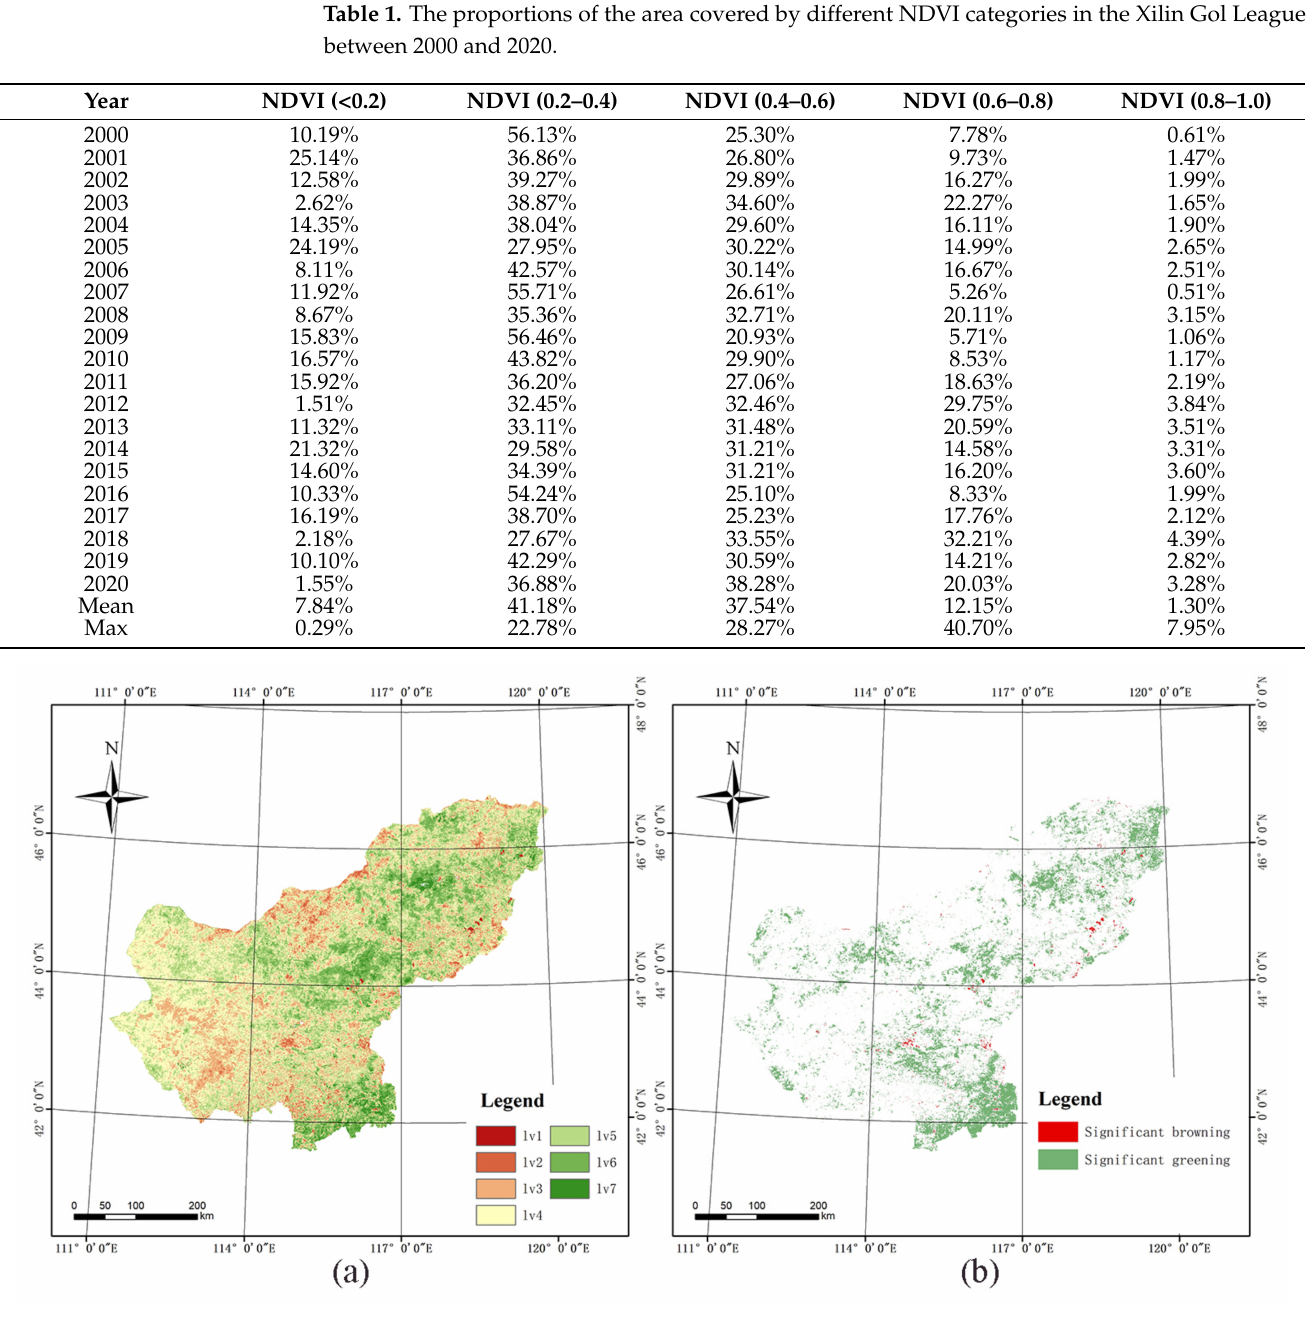
Figure 3. Spatial distribution of the NDVI variation slope in the study area. ( a ) Grading by the natural breakpoint method (Jenks). ( b ) Significance test. Table 2. Statistics of different classifications of the interannual changes of the NDVI in the study area from 2000 to